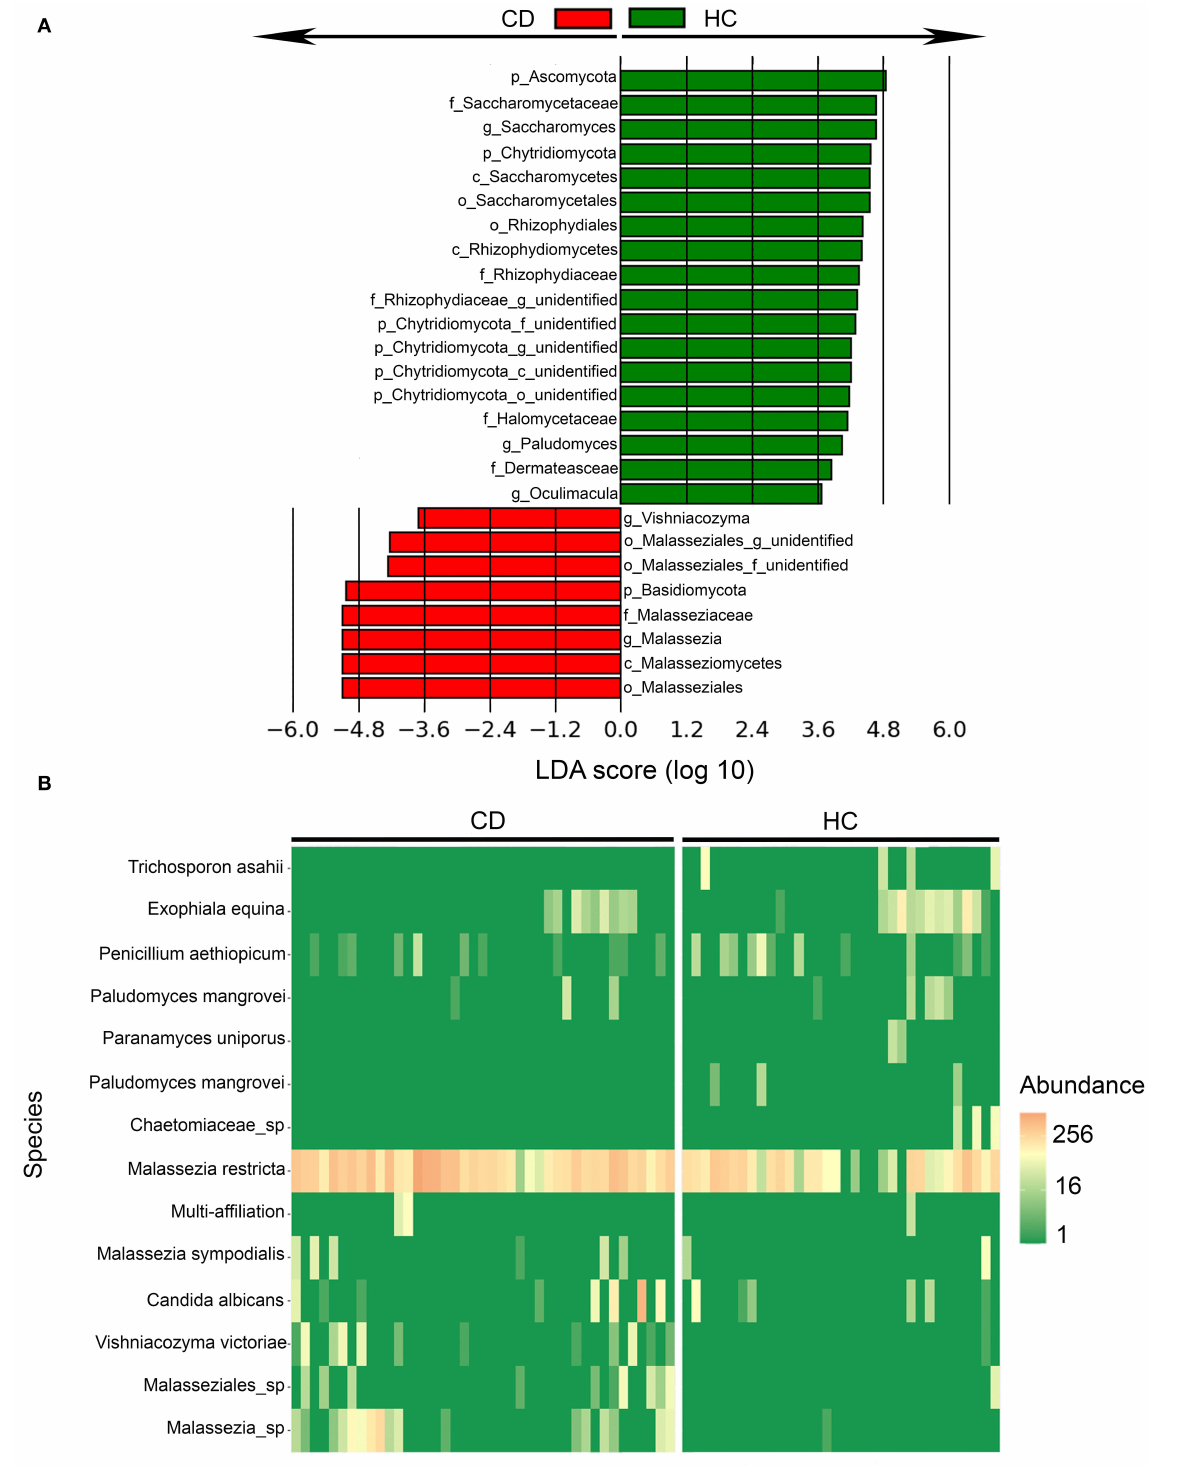
FIGURE2 Fungal taxa were differentially abundant in Crohn’s disease (CD) patients ( n = 44) in comparison to healthy controls (HC) ( n = 40) identified by linear discriminant analysis effect size (LEfSe). (A) Fungal taxa overrepresented in CD patients (red) and HC (green) with Linear Discriminant Analysis (LDA) score for differentially abundant fungal taxa. (B) Heatmap of differentially abundant fungal species between CD and HC mucosal pinch biopsies sampled 5-cm proximal of the ileocecal valve or ileocolic